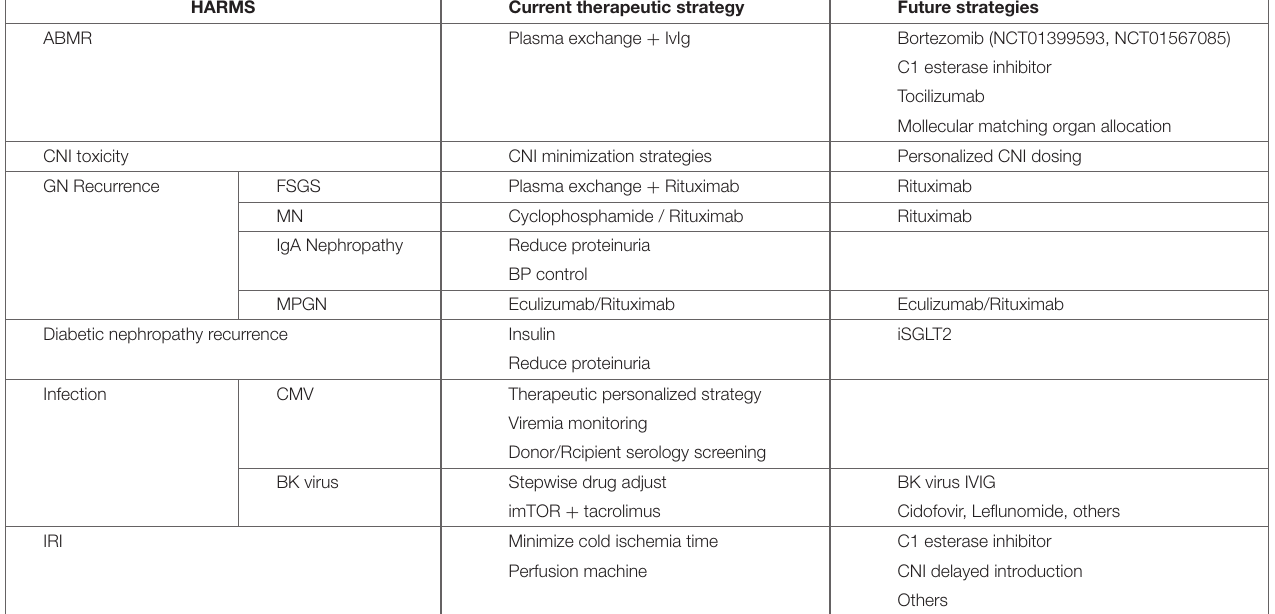
TABLE 1 | Harms from different etiology contribute to CKaD. HARMS Current therapeutic